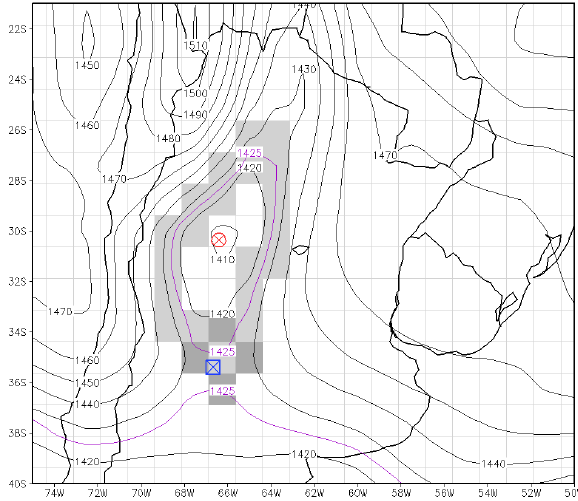
Fig. 4. Testing if NAL is inside the contour level that goes through AC. The contours show φ 850 (m) with the tested contour in purple. The grid-boxes crossed by this contour are highlighted and ACs position is given by the blue box.